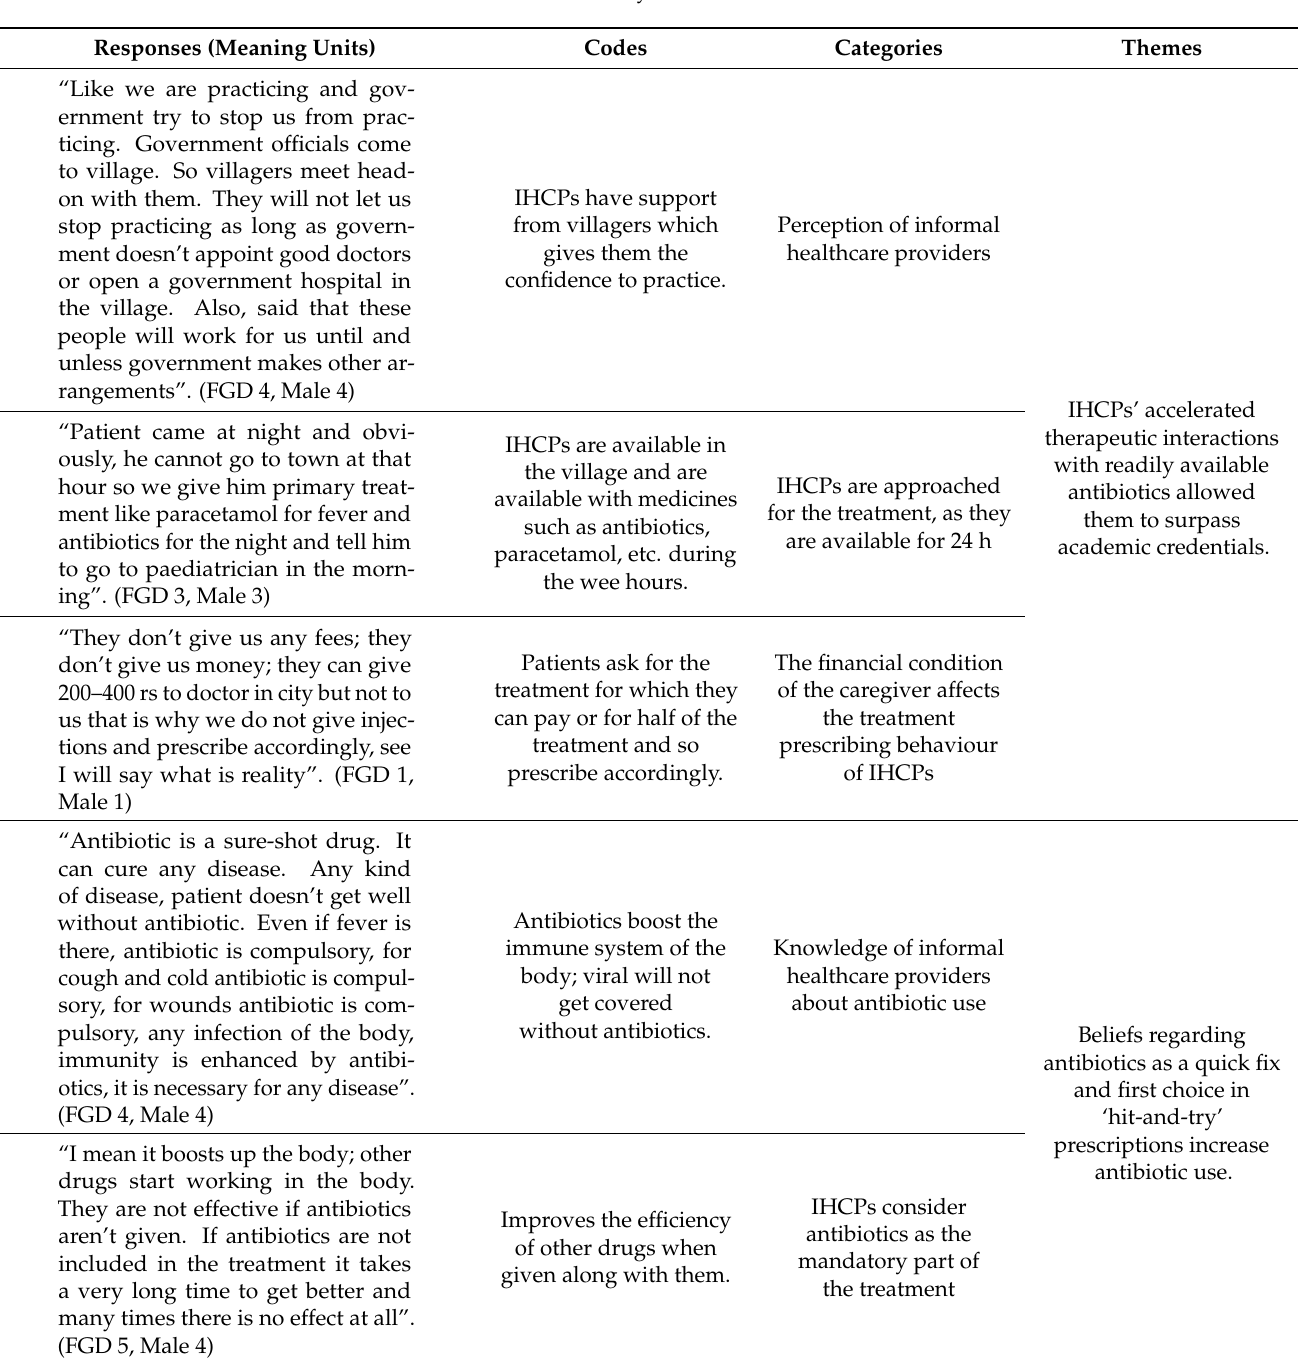
Table 2. Illustrative table of analysis